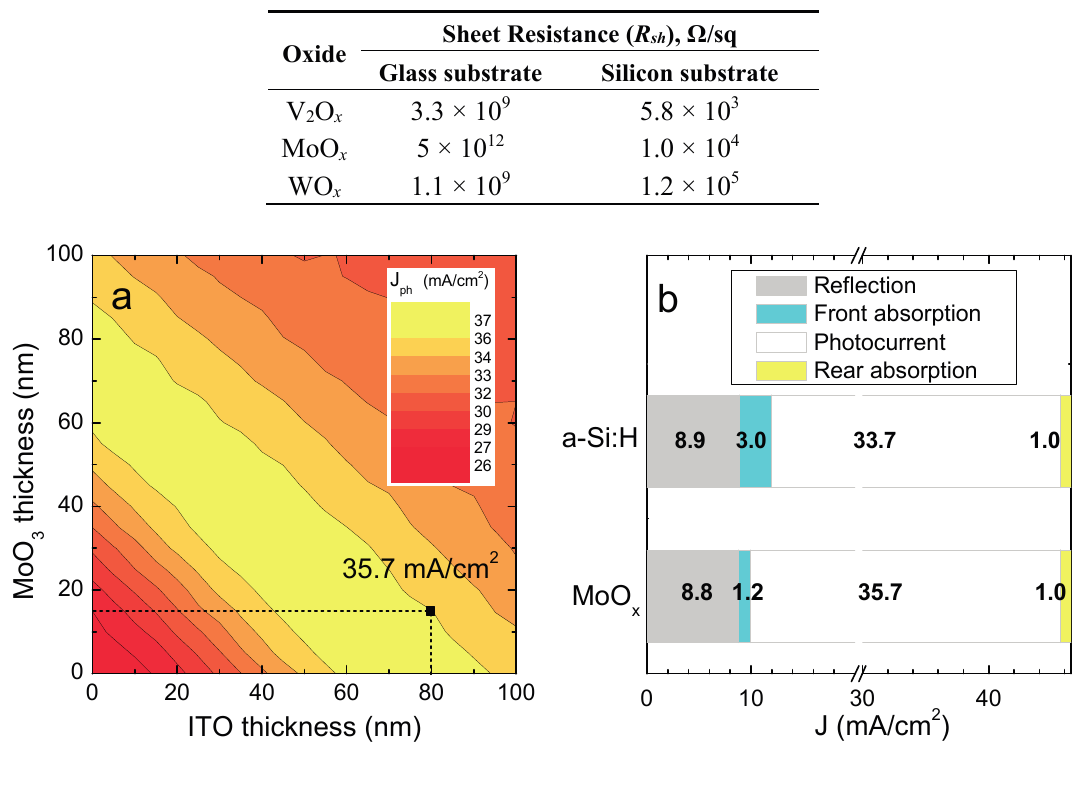
Figure 4. ( a ) Simulated photocurrent density ( J ph ) of the planar solar cell as a function of MoO 3 and Indium-Tin Oxide (ITO) layer thickness, achieving a maximum photocurrent of 35.7 mA/cm 2 for 80 nm ITO and 15 nm MoO 3 . ( b ) Simulated optical losses (in mA/cm 2 ) for MoO x and a-Si:H (15 nm